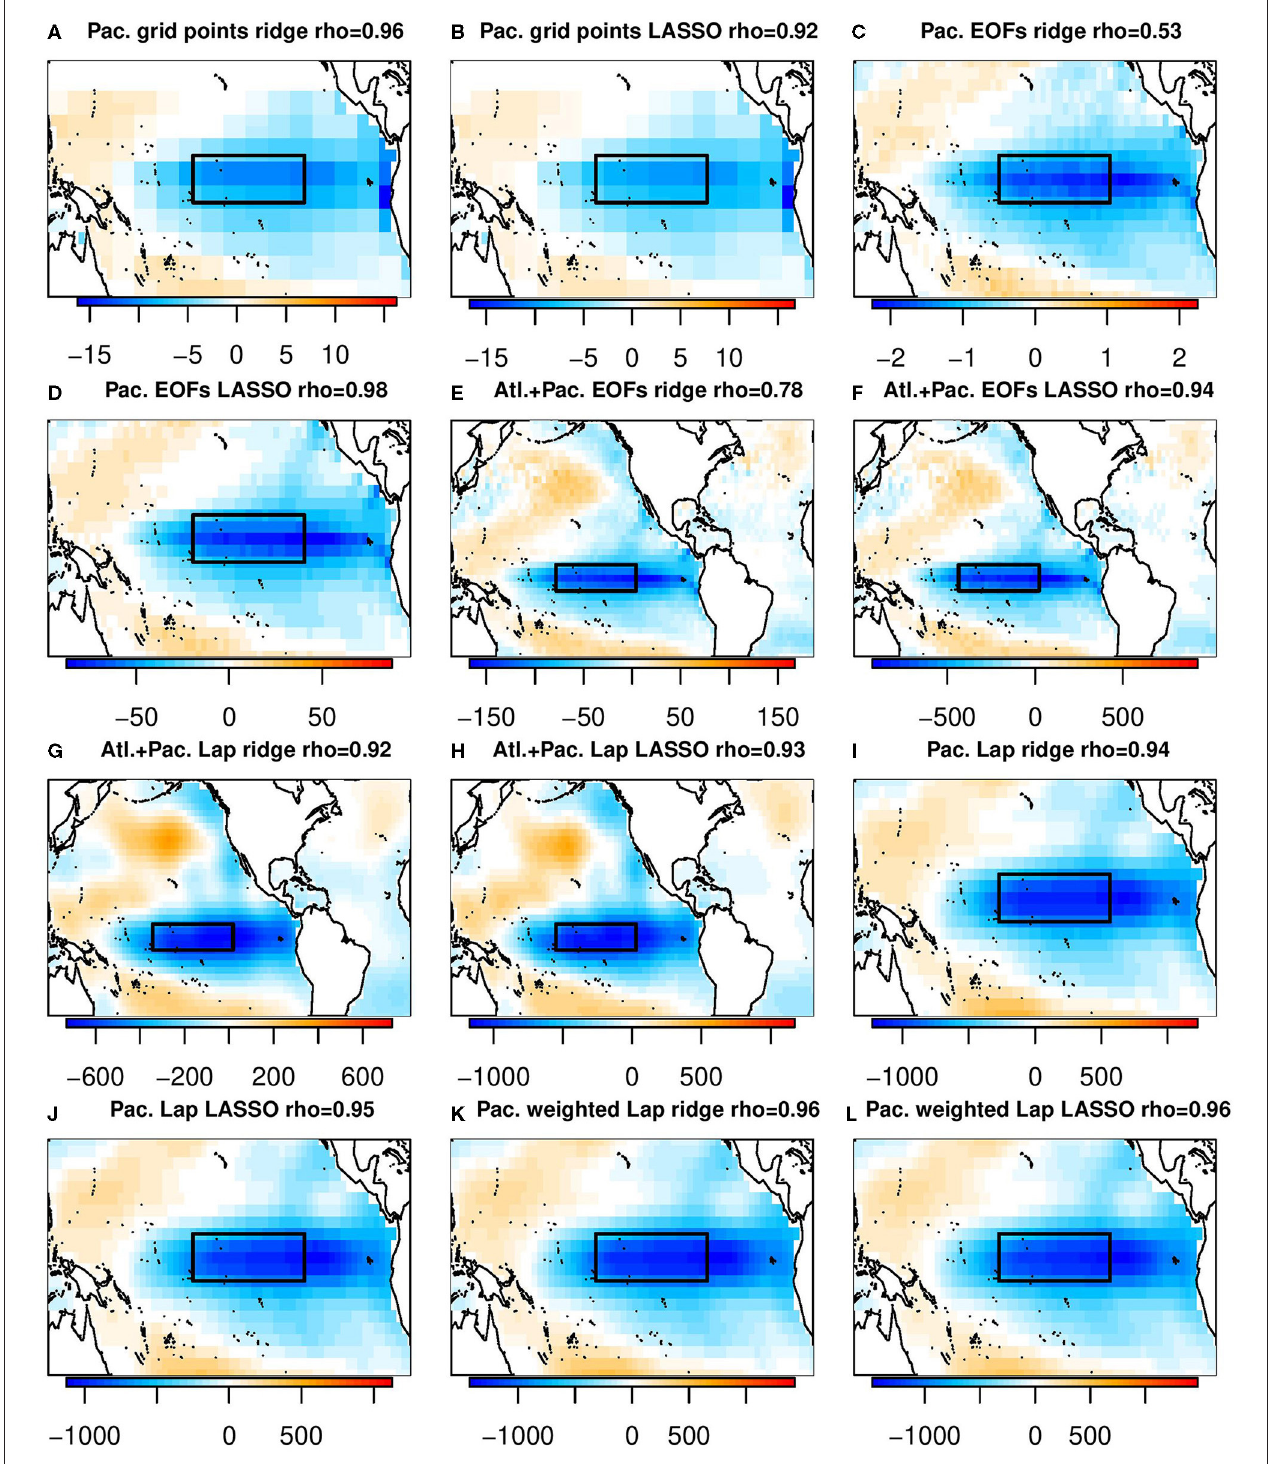
FIGURE 9 | The regression coefficient between each machine learning prediction and the local SST, calculated by regressing the prediction against observed SST. As in Figure 4 , titles of the individual panels indicate the domain, basis set, machine learning algorithm used, and the correlation between the resulting prediction and the Nino3.4 index. (A) Pac. grid points ridge rho = 0.96. (B) Pac. grid points LASSO rho = 0.92. (C) Pac. EOFs ridge rho = 0.53. (D) Pac. EOFs LASSO rho = 0.98. (E) Alt+Pac. EOFs ridge rho = 0.78. (F) Alt+Pac. EOFs LASSO rho = 0.94. (G) Alt+Pac. Lap ridge rho = 0.92. (H) Alt+Pac. Lap LASSO rho = 0.93. (I) Pac. Lap ridge rho = 0.94. (J) Pac. Lap LASSO rho = 0.95. (K) Pac. weighted Lap ridge rho = 0.96. (L) Pac. weighted Lap LASSO rho = 0.96.